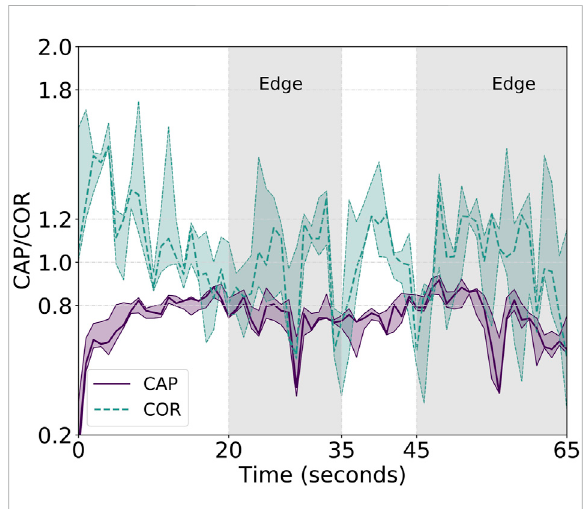
FIGURE 9 Reported CAP — solid purple line — metric and COR — dashed green line — metric for the real- fi eld experiments with the UVDAR sensing technology. Higher y-values show better CAP performance. Close to 1 y-values show better COR